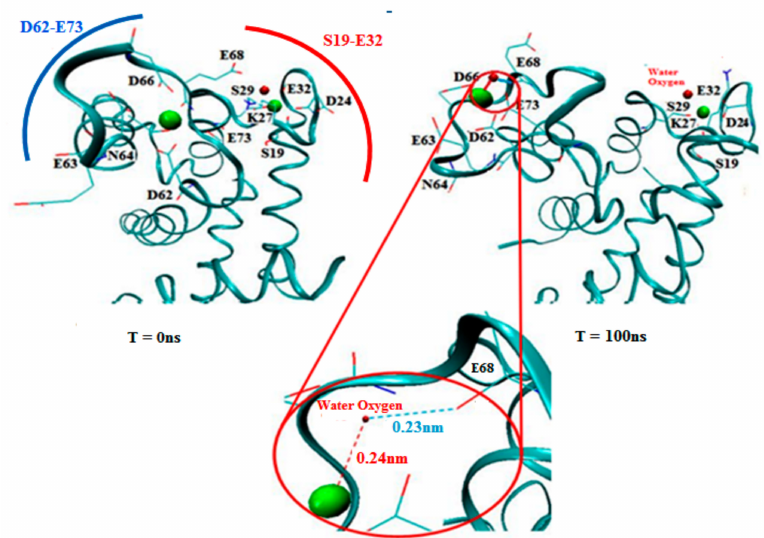
Figure 7. Visualization of subunit B of holo S100A1 after simulation. Residue atoms closer than 0.3 nm are denoted as a line (oxygen in red, carbon in cyan, and nitrogen in blue). The left frame at T = 0 depicts the inverted position of subunit B. Right frame B represents the propensities of binding residues with Ca 2 + at T = 100 ns. A magnified view in the red circle denotes the H-bond formation where the oxygen atom of E68 forms a H-bond with Ca 2 + via oxygen in water. Ca 2 + are also shown (in CPK style) along with the relevant